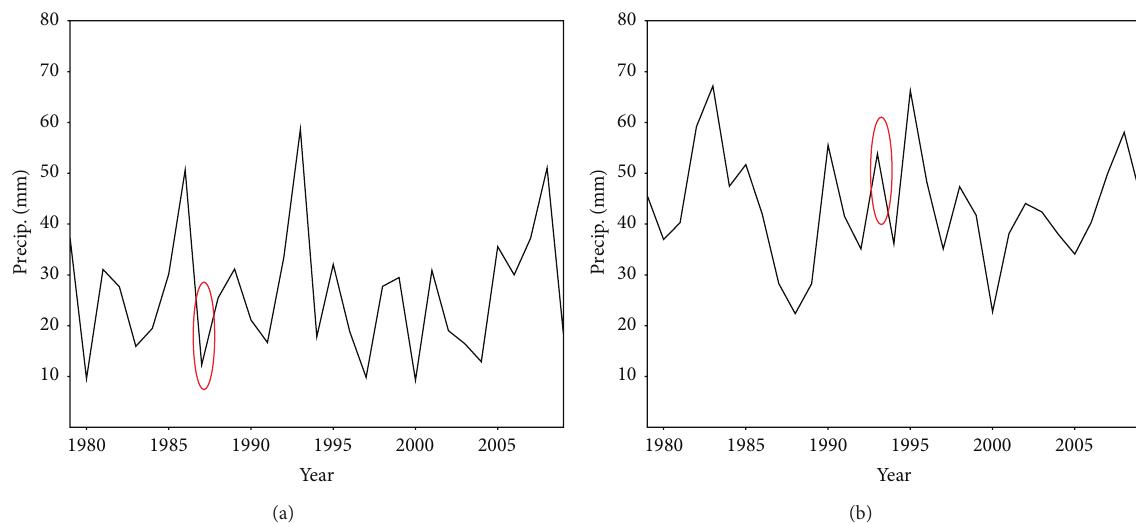
Figure 7: Storm-rainfall index for (a) AMJ, (b) JAS (units: mm). Red circles show 1988 drought and 1993 flood, respectively.